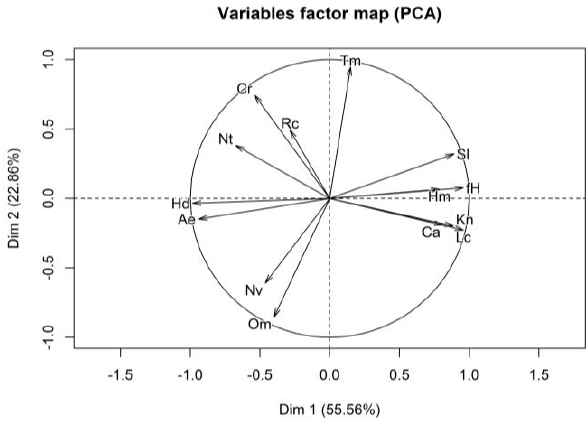
Fig. 3. Analysis of the main components (PCA) of correlations between environmental factors (according to a phytoindicational assessment of the vegetation of afforestation belts syntaxa)